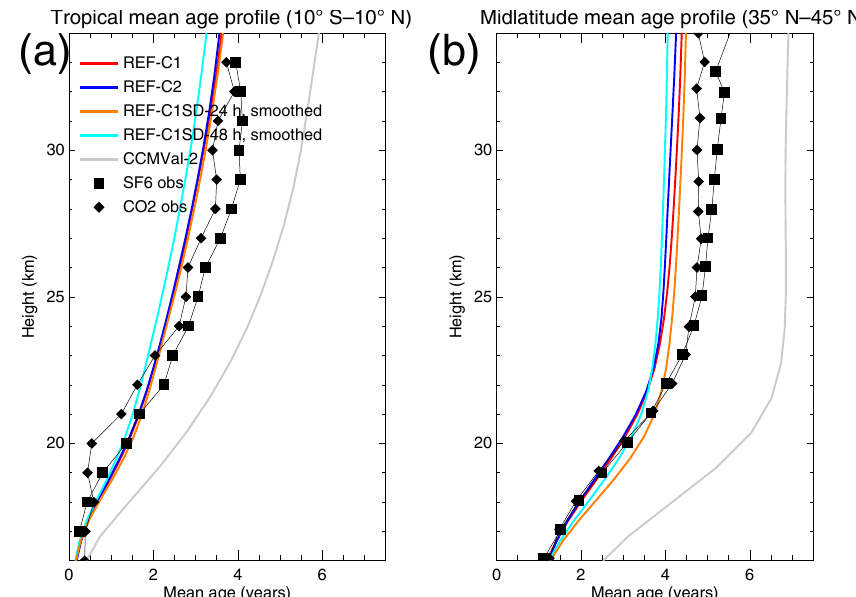
Figure 11. Stratospheric age of air (1990–2010) in the (a) tropics (observations from Andrews et al., 2001) and (b) Northern Hemisphere midlatitudes (observations from Engel et al., 2009). The period 1990–2010 was chosen for CCMI model simulations to allow for age of air to adjust during the first 10 years of the nudged simulations. The period 1980–2000 was used for the CCMVal-2 model simulation (historical period only). The exact period chosen makes very little difference to the diagnosed age of air (not